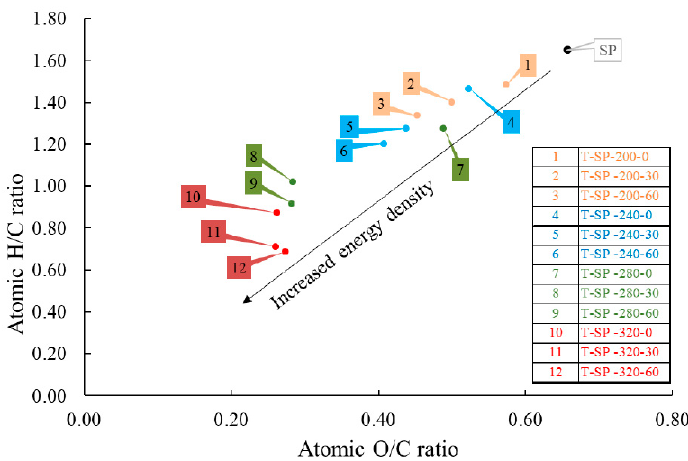
Figure 3. van Krevelen diagram of the SP-torrefied products.